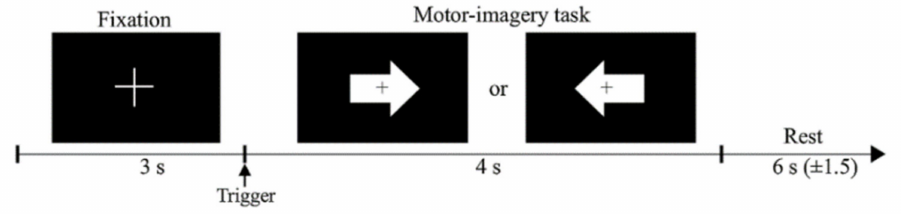
Figure 6. The experimental design for binary class MI. The experimental description was provided by Lee et al. [8].